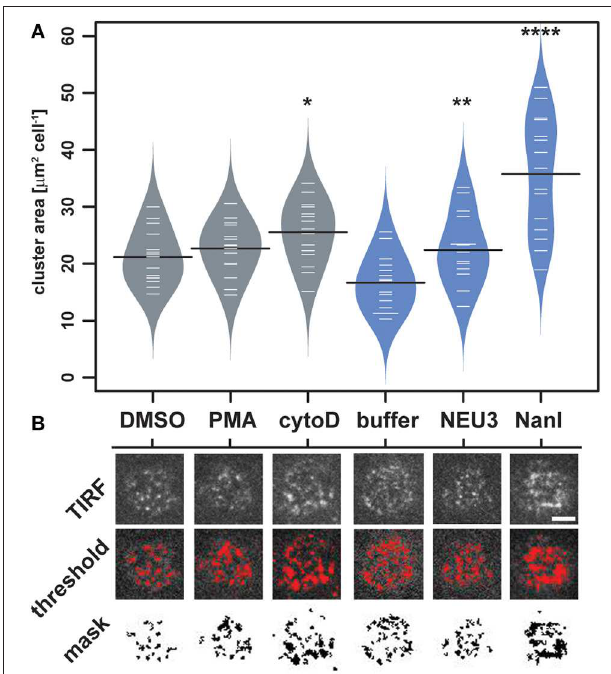
FIGURE 4 | Changes in LFA-1 clustering after neuraminidase treatment. The amount of clustered LFA-1 on individual cells was determined using TIRF imaging. Cells were labeled with a TS2/4-Cy5 antibody conjugate, and 15 individual cells were compared for each condition. (A) Clusters that were larger than 4 pixel 2 were measured using ImageJ, and the average area was tabulated for each cell. Data are plotted using a beanplot, with solid lines representing the mean of each population (Kampstra, 2008). (B) Representative TIRF images for individual cells are shown from each condition. A mask was generated from the TIRF image using a threshold for quantitation. Data were compared to the appropriate control using a t -test to determine p -values; * p ≤ 0.05; ** p ≤ 0.01; **** p ≤ 0.0001. Scale bar = 5 µ m.